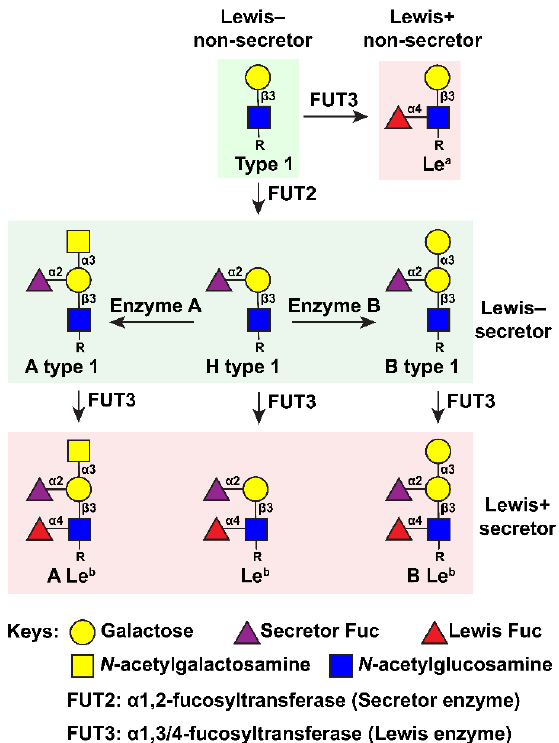
Figure 1. HBGA-chain modification pathways on the type-1 structure. Adapted from Hu et al.,